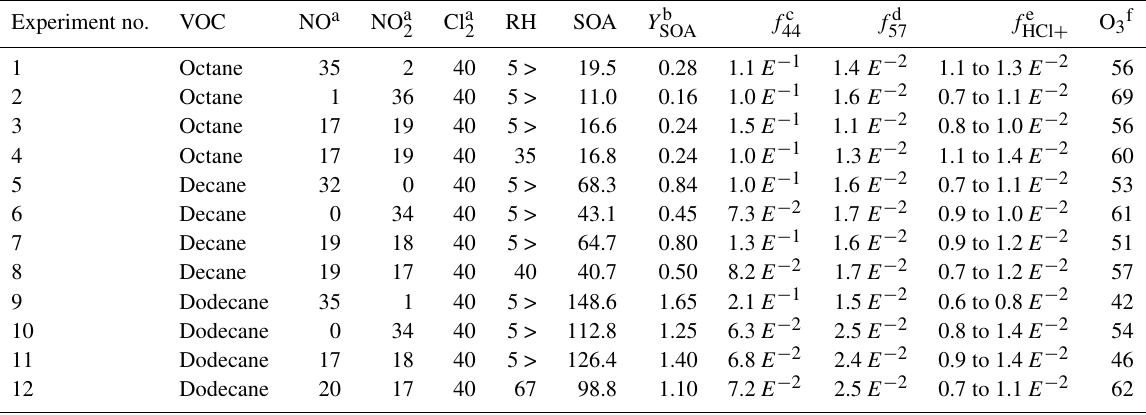
Table 1. Summary of experimental conditions and results. Experiment